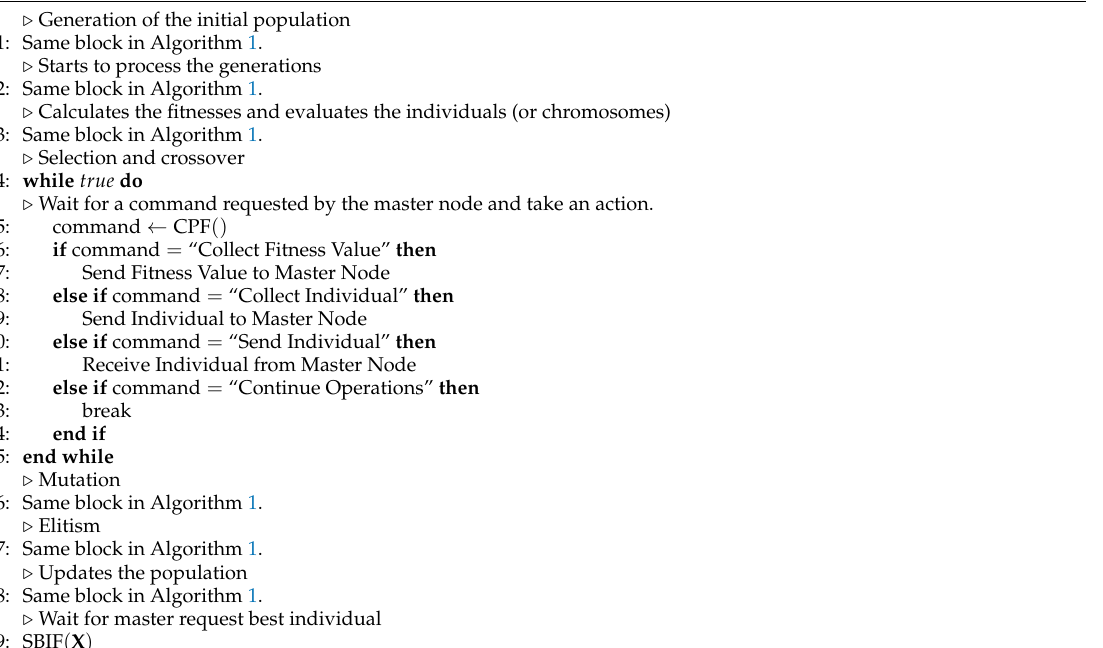
Algorithm 3 Distributed Genetic Algorithm